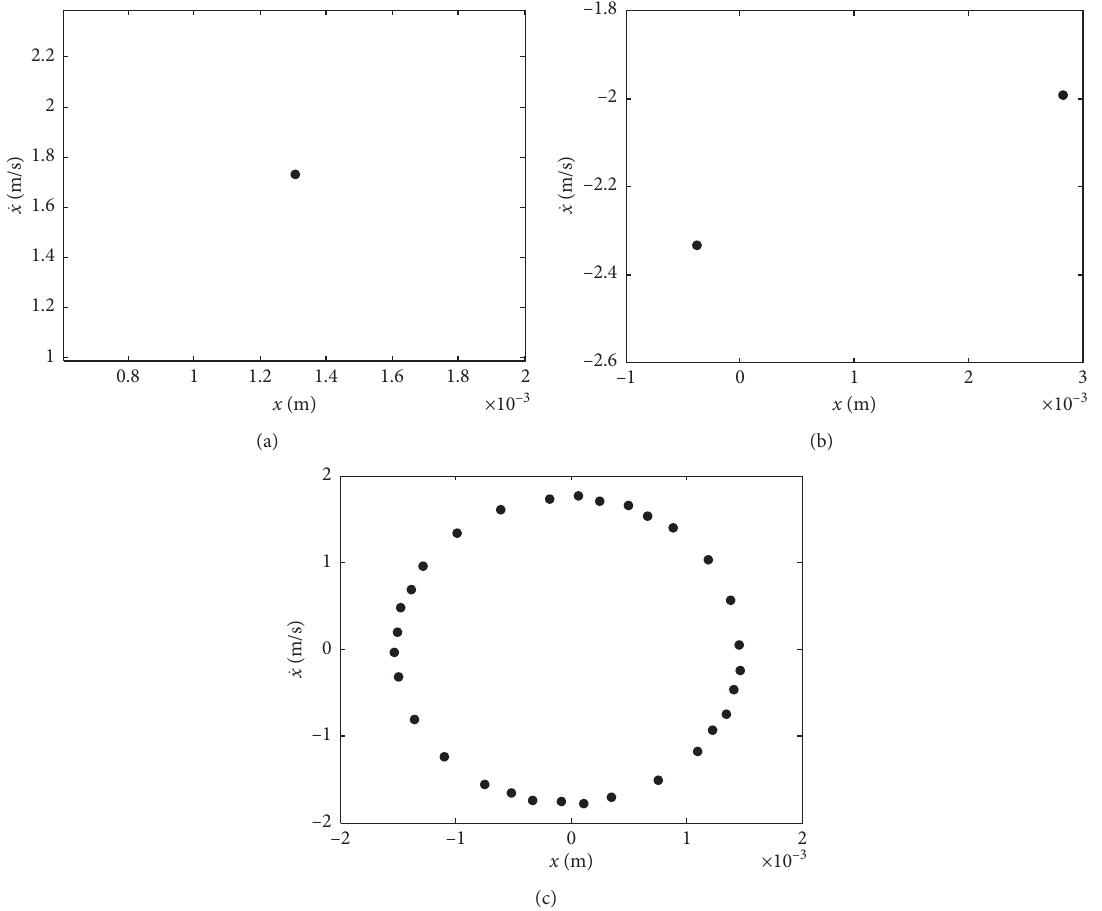
Figure 15: Poincare section of horizontal vibration of the rolling mill rolls under varying external excitation amplitude, (a) F F 0 � 5.95 e 5N, and (c) F 0 � 6.20 e